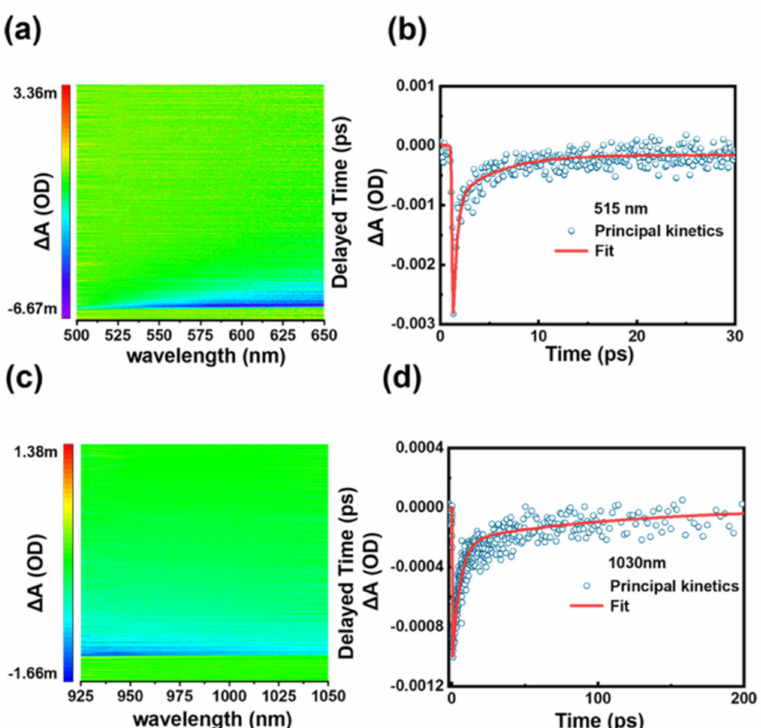
Figure 4. ( a , c ) the temporally and spectrally resolved transient absorption signal with probe light from 500 nm to 650 nm and from 925 nm to 1050 nm, respectively. ( b , d ) the dynamic curves of BQDs for various at 515 nm and 1030 nm,